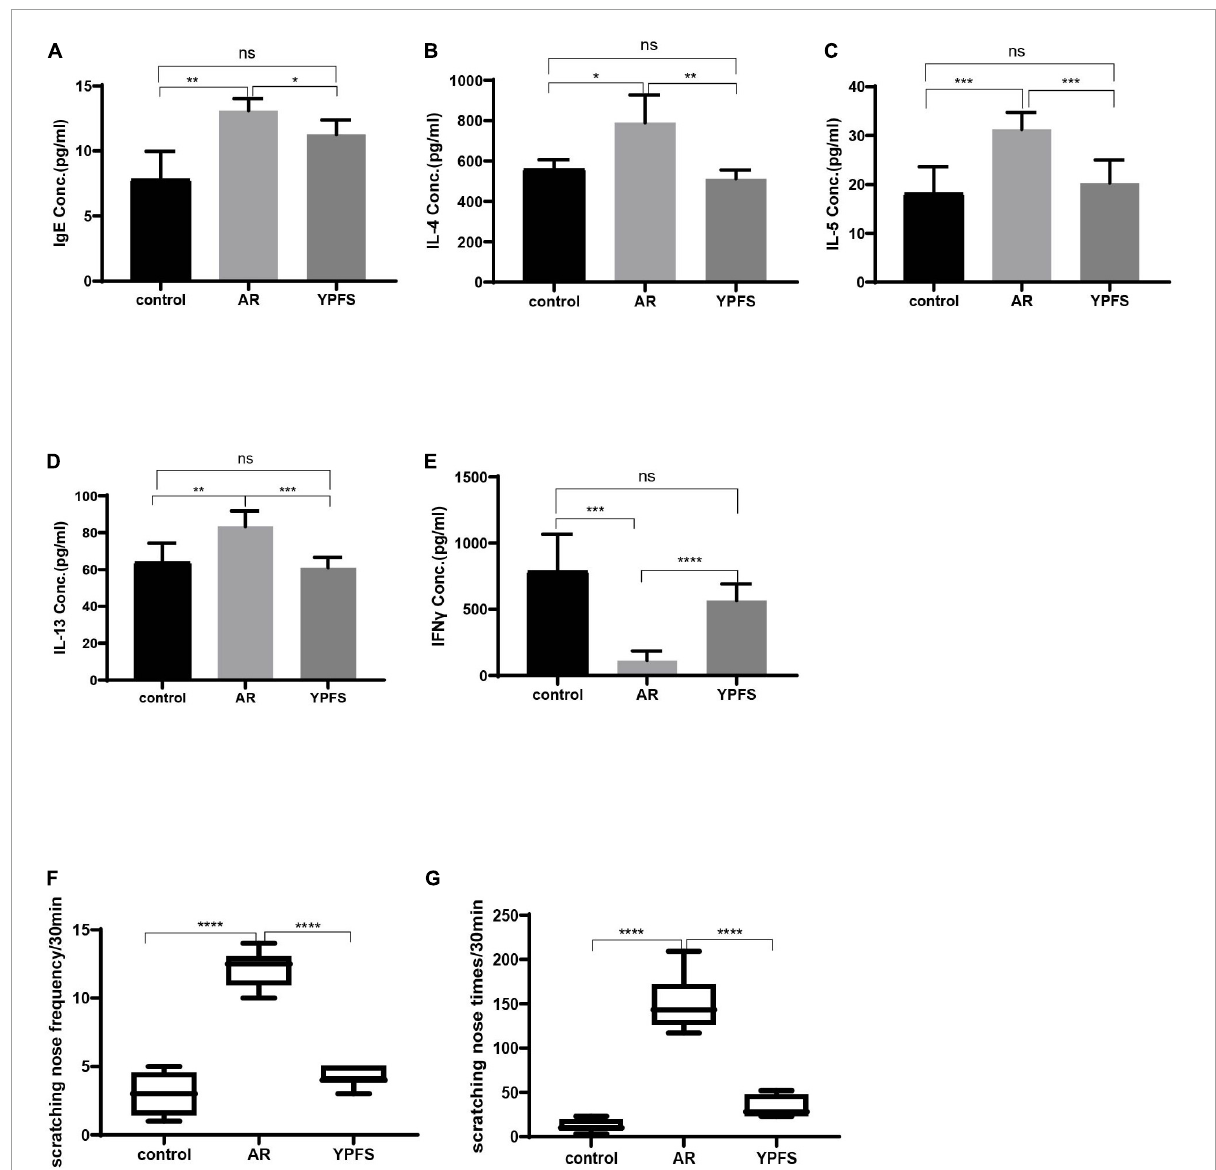
FIGURE6 YPFS relieved inflammatory reactions of ovalbumin (OVA)-induced AR. Comparisons of IgE (A) , IL-4 (B) , IL-5 (C) , IL-13 (D) , and IFN γ (E) concentrations (Conc.) in the serum of mice. The frequency (F) and times (G) of nasal scratching scores in mice for 30 min in the control group, OVA-induced AR group, and YPFS group. * P < 0.05, ** P < 0.01, *** P < 0.001, **** P < 0.0001; n = 6. YPFS, YU-Pingfeng San; AR, allergic